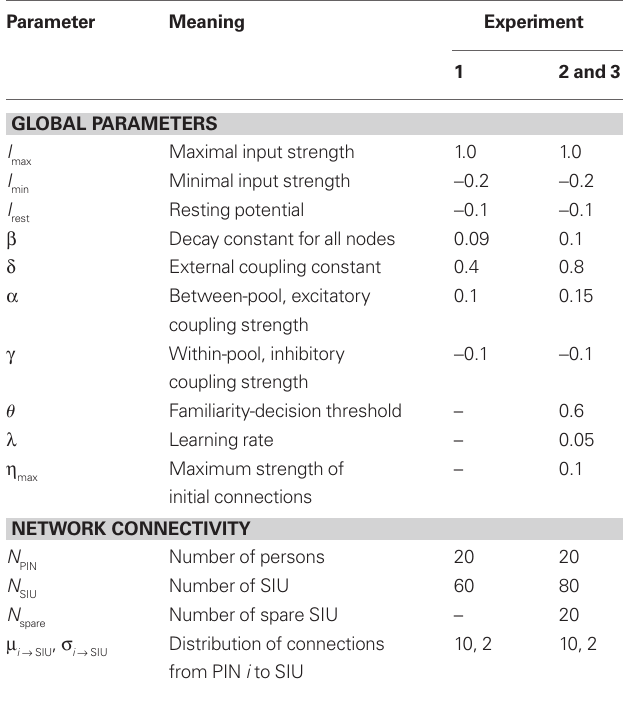
Table A2 | Model parameters and their values in the different simulations.